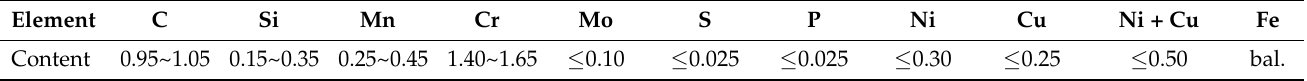
Table 3. Chemical composition of GCr15